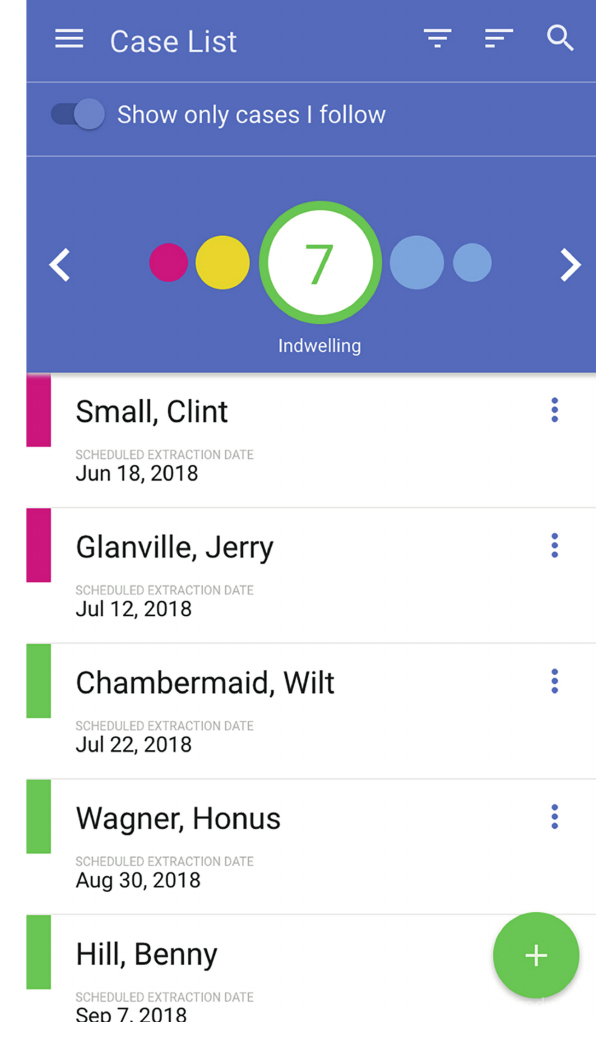
Figure 2 - A view of the UST dashboard showing overdue, incomplete, indwelling, within 2 weeks and extracted cases (Images© Copyright visible Health, Inc. Created for